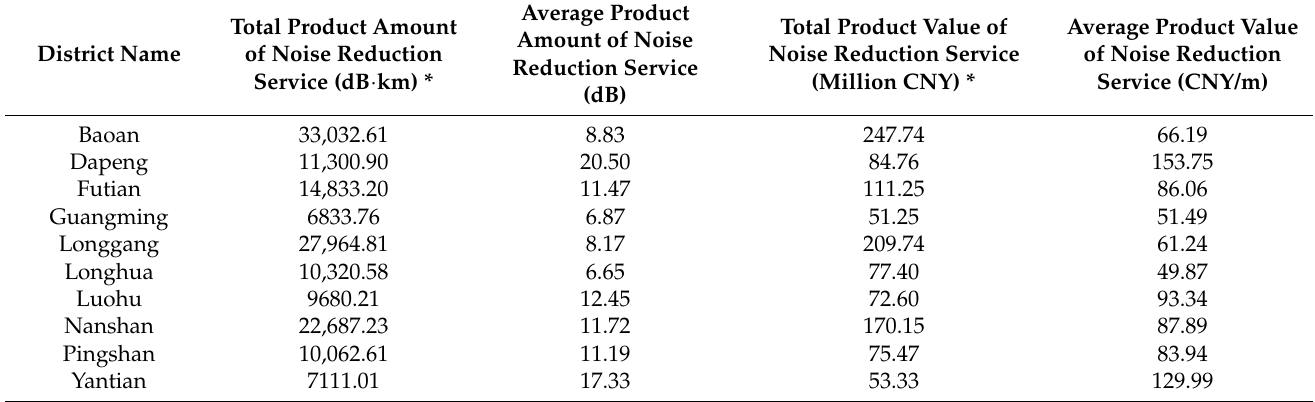
Table 2. Product amount and value of the noise reduction service of roadside green belts in each district of Shenzhen.